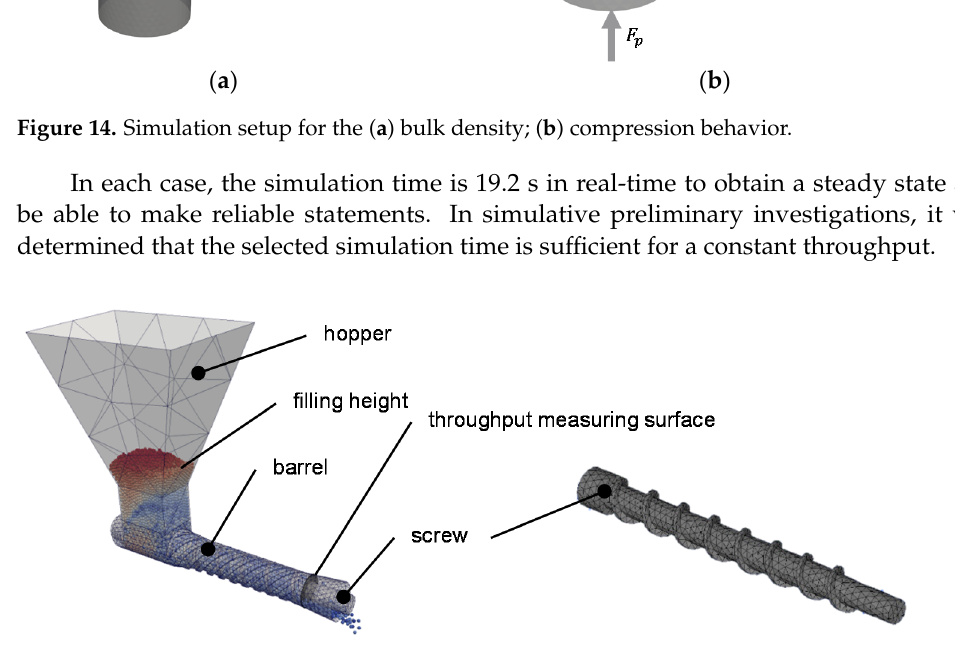
Figure 15. Simulation setup to determine the solids conveying.